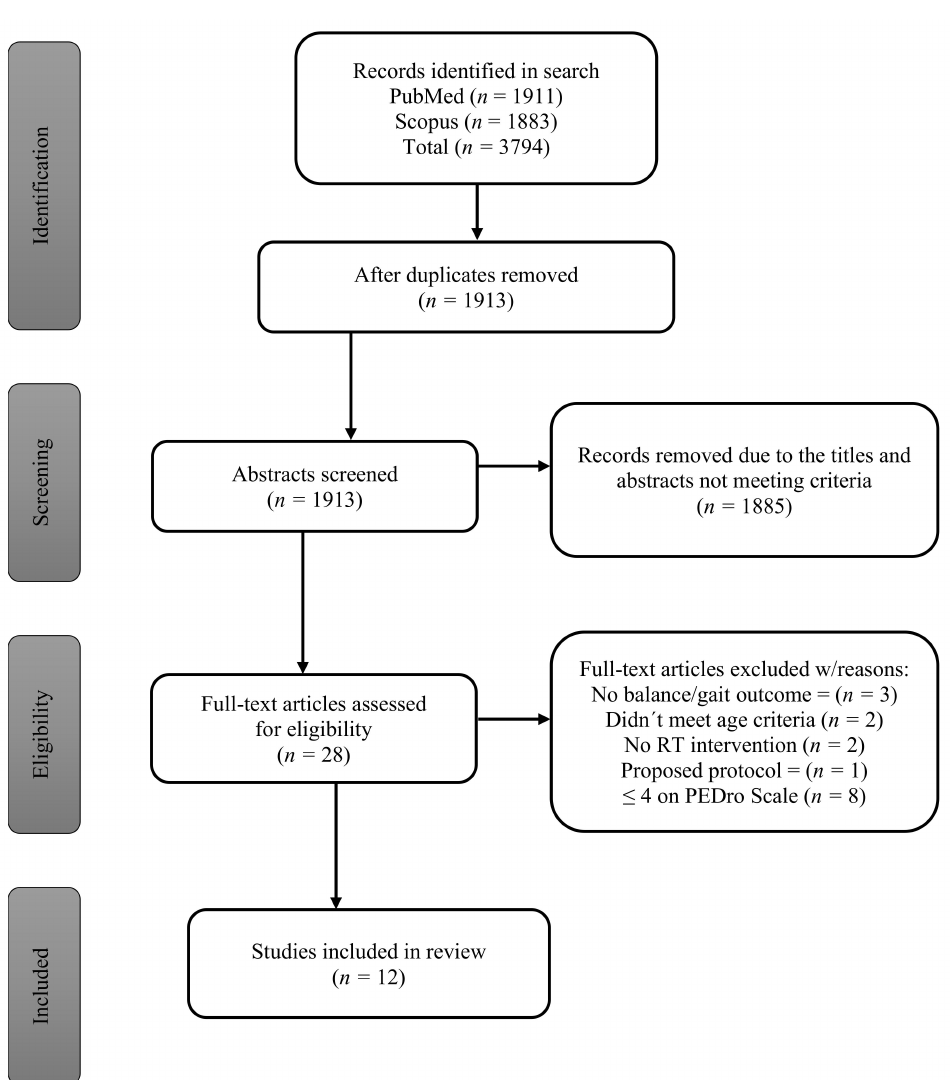
Figure 1. Article selection